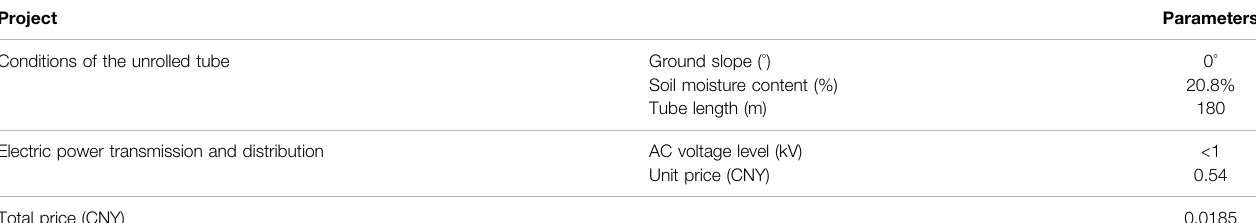
TABLE 7 | The operating costs of the one-time unrolled tube.